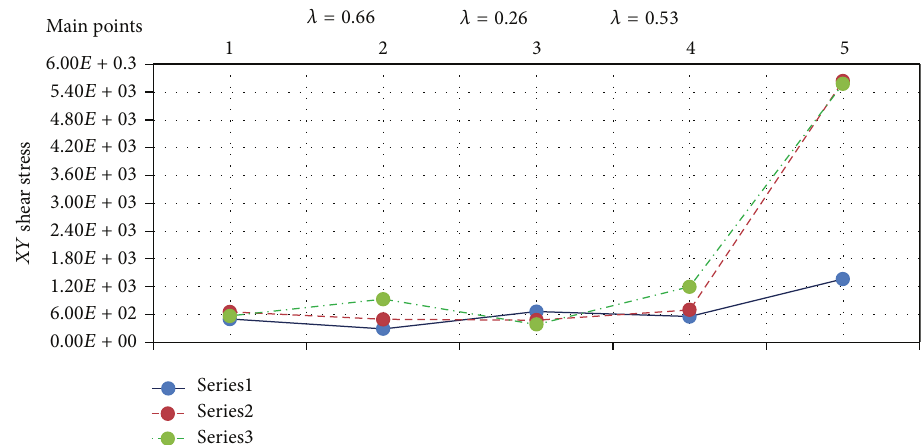
Figure 11: 𝑋𝑌 Shear stress in the end of earthquake for models; horizontal axis is main points, and vertical axis is shear stress (Kg/m 2 ).